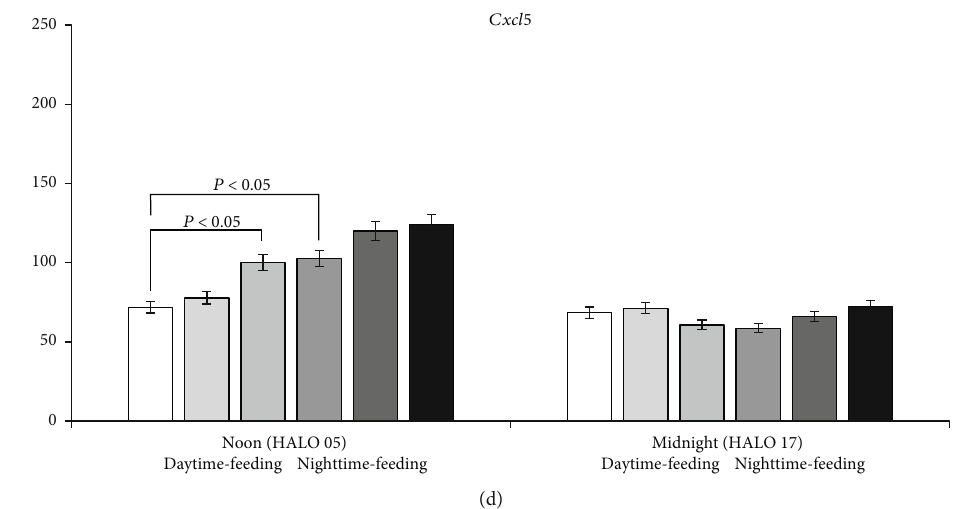
Figure 3: Circadian changes of mRNA transcription of in fl ammation-related genes in mouse liver tissues. mRNA expression of (a) Nrf2 ; (b) Ppar- γ ; (c) Nf κ b ( p65 ); and (d) Cxcl5 . Signi fi cant di ff erences are shown by horizontal lines ( P < 0 : 05